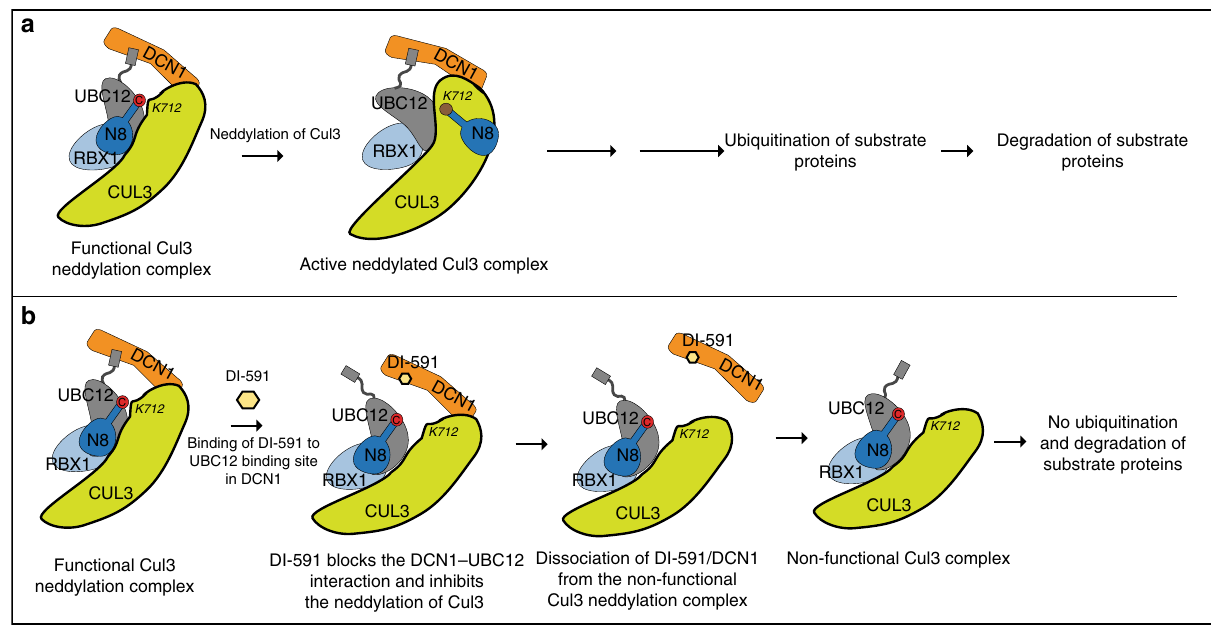
Fig. 6 Proposed model for inhibition of cullin 3 neddylation by DI-591. a Proposed activation of the cullin 3 neddylation complex. DCN1, functioning as a co- E3, is required for the formation of a functional cullin 3 neddylation complex to facilitate the transfer of NEDD8 from UBC12 to the K712 residue of cullin 3. The active neddylated cullin 3 complex proceeds to form a functional cullin 3 ring ubiquitin ligase complex that performs ubiquitination of substrate proteins, ultimately resulting in substrate protein degradation by the proteasome. b Proposed model for inactivation of the functional cullin 3 complex by DCN1 inhibitor DI-591. DI-591 binds to the UBC12 binding site in DNC1, leading to dissociation of DCN1 from the functional complex and resulting in